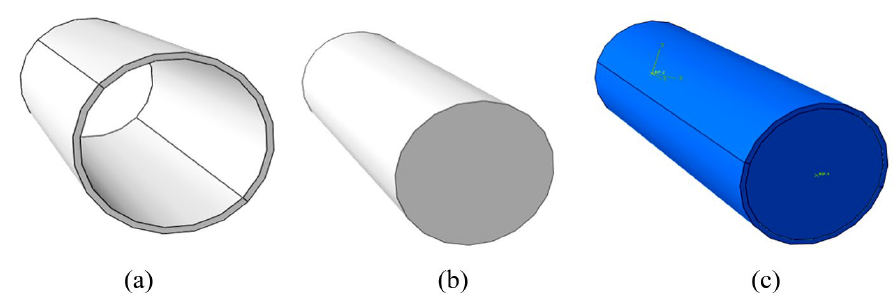
Figure 3. Schematization: (a) steel tube, (b) concrete core, and (c) complete